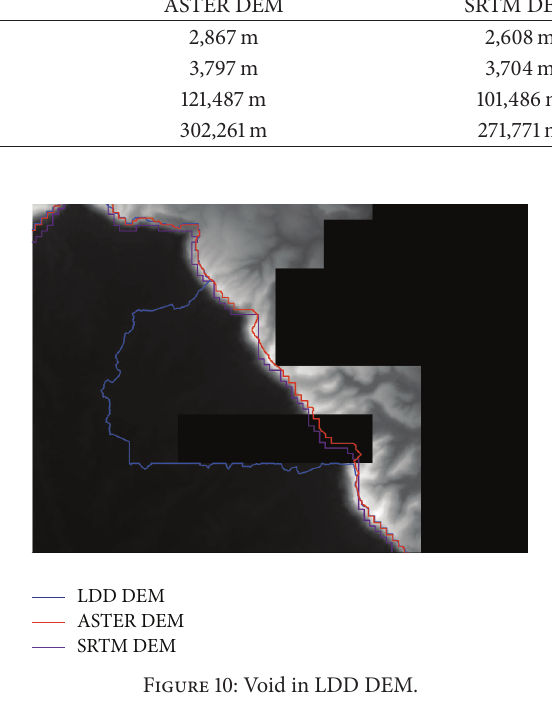
Figure 10: Void in LDD DEM.